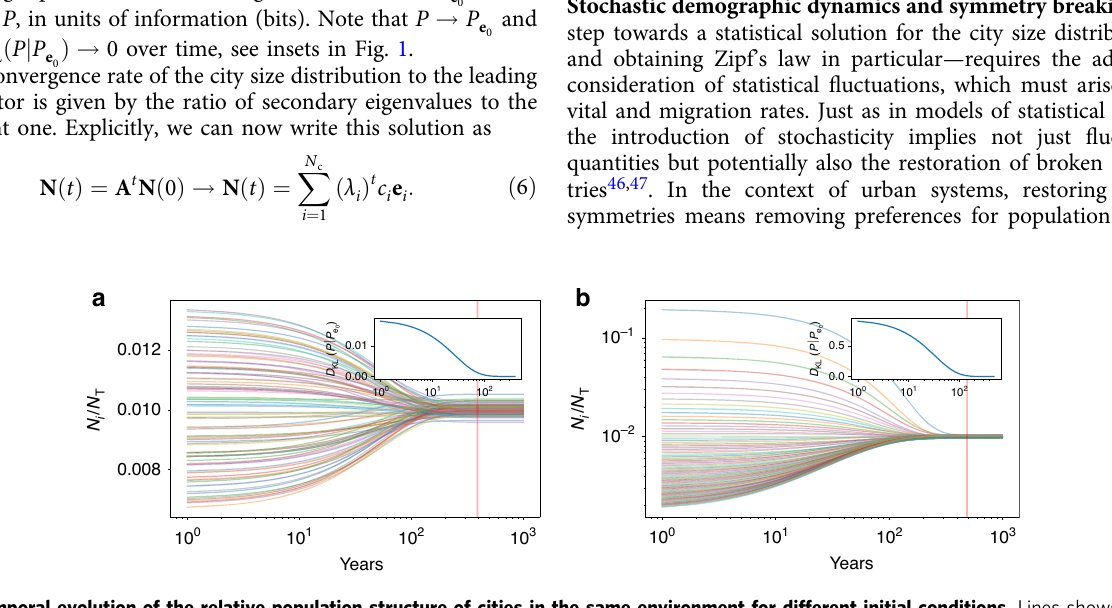
Fig. 1 Temporal evolution of the relative population structure of cities in the same environment for different initial conditions. Lines shows the trajectory of each city in terms of the fraction its population, N i to the total N T . a shows an initial situation where all cities start out with similar sizes, whereas in b they are initiated following Zipf's law (shown in log-scale). In both cases, the relative city size distribution eventually becomes stationary at long times (vertical red line) with the same population structure. This is given by the eigenvector e 0 , corresponding to the leading eigenvalue of the environment. The insets show how the system converges in both cases to this common structure set by the environment, because the Kullback – Leibler ð P j P Þ approaches zero at late divergence D KL e 0